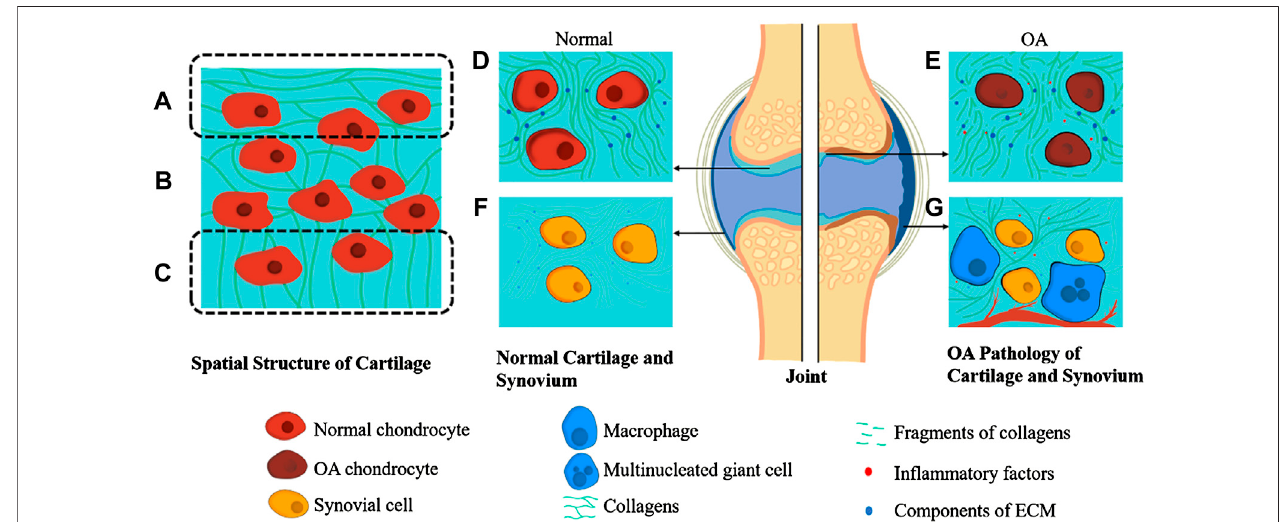
FIGURE 1 | Pathology of OA Joint and Spatial Structure of Cartilage. The spatial structure of cartilage is divided into three parts. The collagens in super fi cial zone arealignedparallel tothetissuesurface (A) .Atthesametime,theyarerandomlyorientatedinthemiddlezone (B) andareperpendiculartotheinterfaceofcartilage and subchondral bone in deep zone (C) . Normal articular cartilage contains chondrocytes and ECM full of collagens, proteoglycans, and glycosaminoglycans (D) . In contrast, the OA cartilage is recognized by the apoptosis of chondrocytes and ECM fragments (E) . Normal synovium consists of synovial cells and synovial ECM, which is similar to cartilage (F) . At the same time, the OA synovium is characterized by in fi ltration of macrophages, multinucleated giant cells, fi brosis, and angiogenesis (G) .